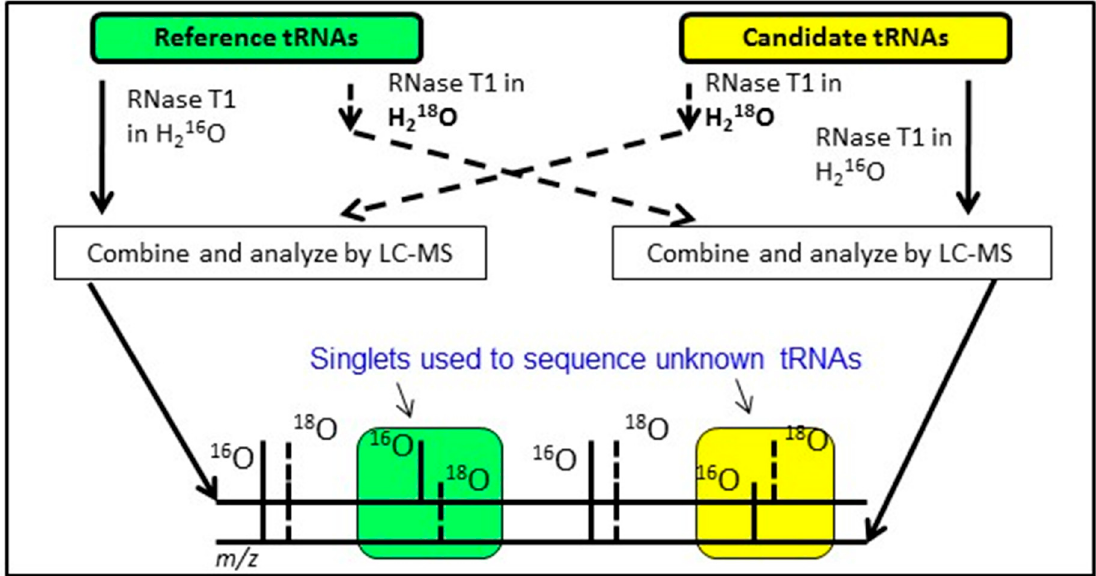
Figure 6. Schematic outline of comparative sequencing of total transfer ribonucleic acids (tRNAs) from an unknown (candidate) organism using a known (reference) organism by isotope-labeling and LC-MS. tRNA endonuclease digestion products that are equivalent between organisms will appear as doublets (separated by 2 Da) in the mass spectral data; digestion products that are different between the two organisms will appear as a singlet. Figure adapted from [67] with permission.